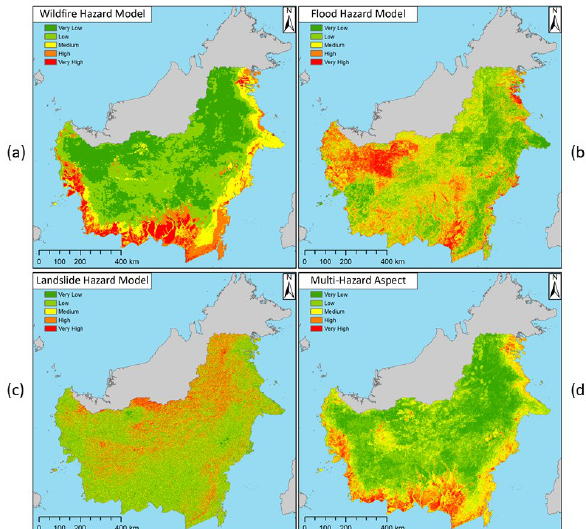
Figure 5 . Multi -hazard aspect (note: very high multi-hazard aspect means the location has a very high intensity of multi- hazard)